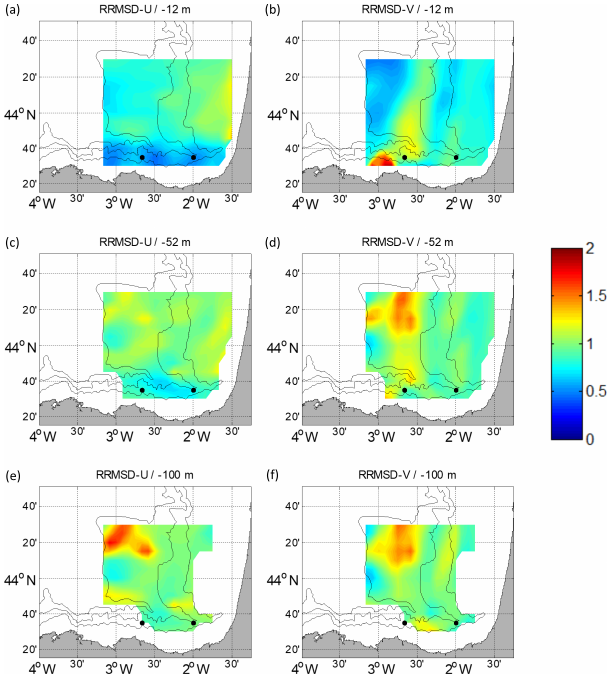
Figure 6. RRMSD maps for the summer period between the ref- erence fields and the outputs of the ROOI with GLORYS-LR for U (a, c, e) and V (b, d, f) . Different depths are considered: − 12m (a, b) , − 52m (c, d) and − 100m (e, f) . The black dots depict the locations of the current vertical